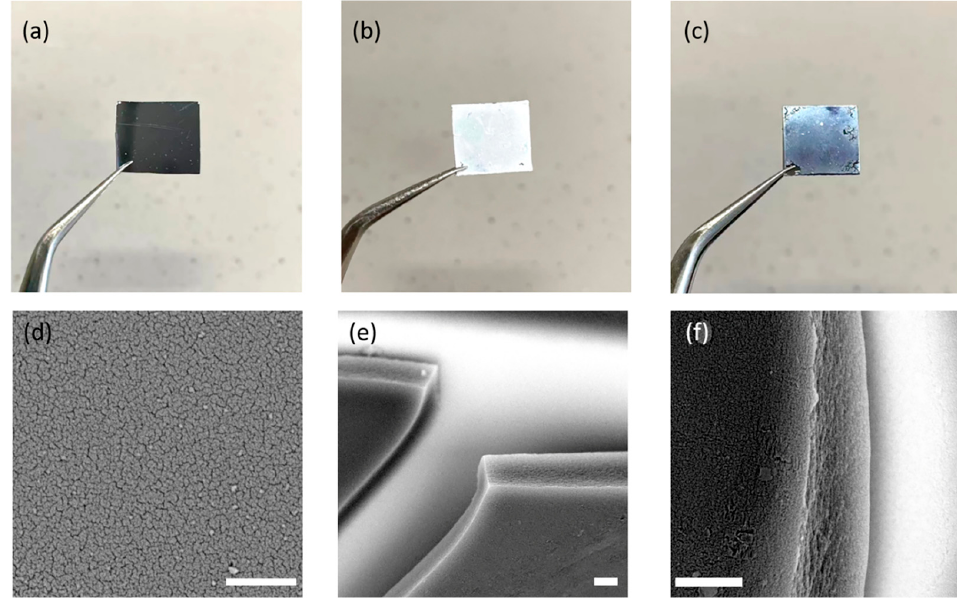
Figure 6. Photographs of the porous silica support ( a ), FDU-HOF-1 film spin-coated on the silica support before ( b ) and after ( c ) thermal treatment at 648 K for 12 h. SEM images of the top view ( d ) and side view ( e , f ) of TC-HOF-TF-12 (the scale bar is 3 µ